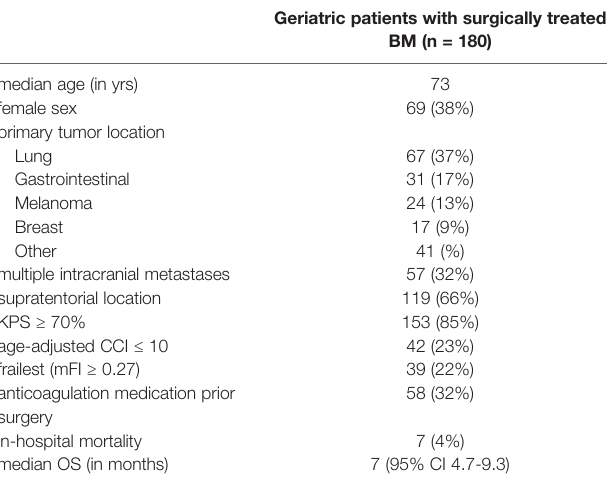
TABLE 1 | Patient